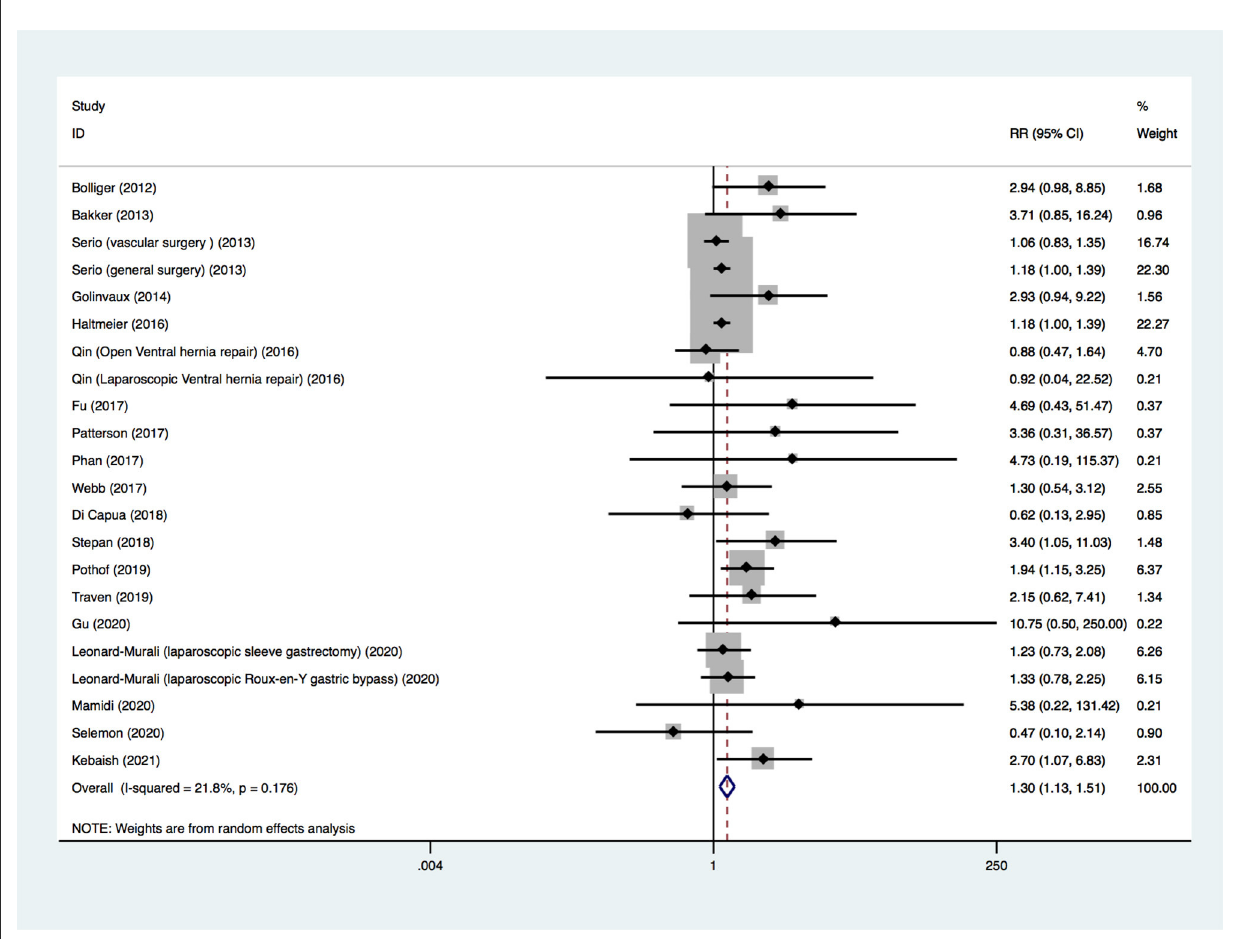
FIGURE2 Forest plot for risk of 30-day